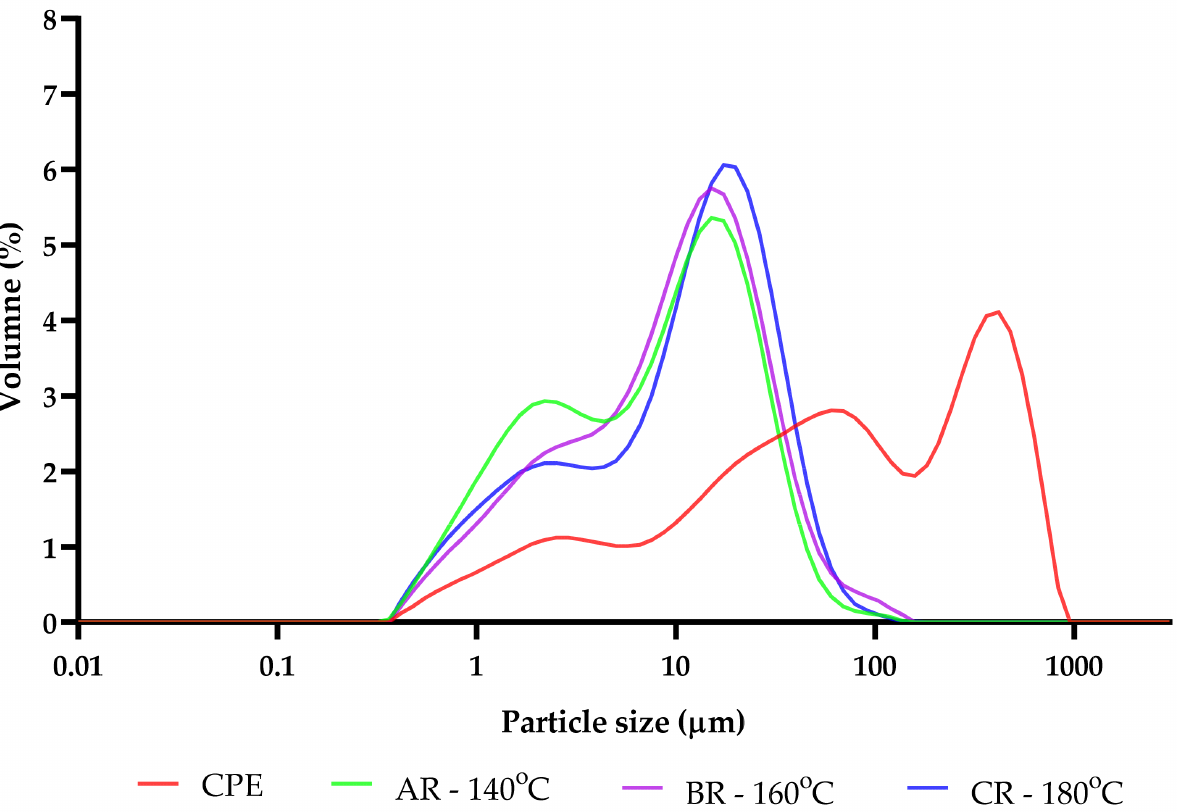
Figure 4. The distribution of the particle sizes of initial and reconstituted samples. CPE: Camelina Press Cake Extract; AR—140 ◦ C: reconstituted sample spray-dried at 140 ◦ C; BR—160 ◦ C: reconsti- tuted sample spray-dried at 160 ◦ C; CR—180 ◦ C: reconstituted sample spray-dried at 180 ◦